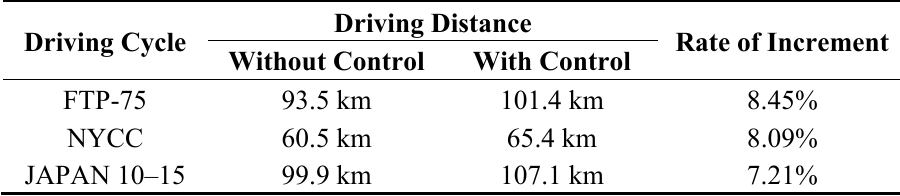
Table 7. Simulation results of efficiency testing at various driving